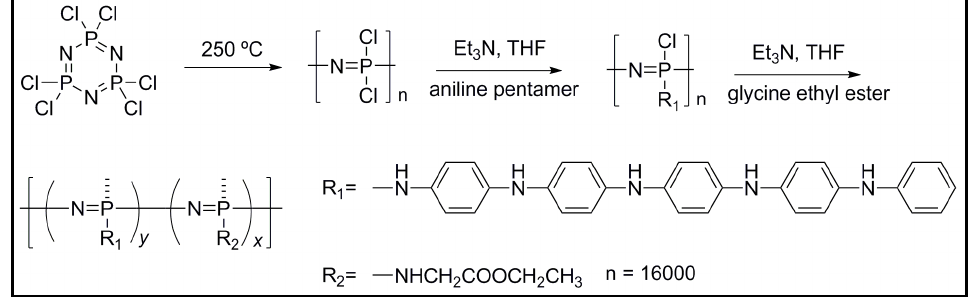
(aniline pentamer) x y